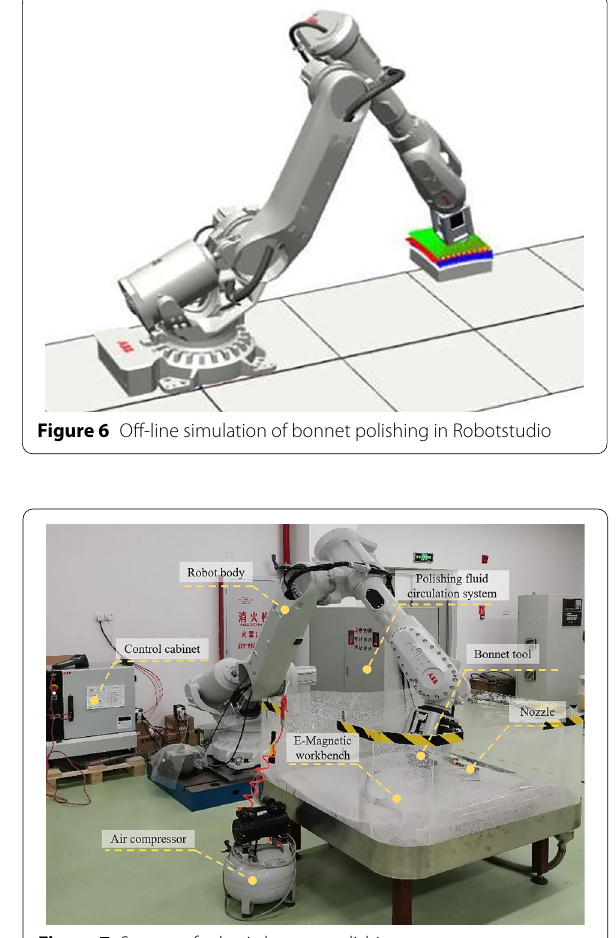
Figure 7 System of robotic bonnet polishing